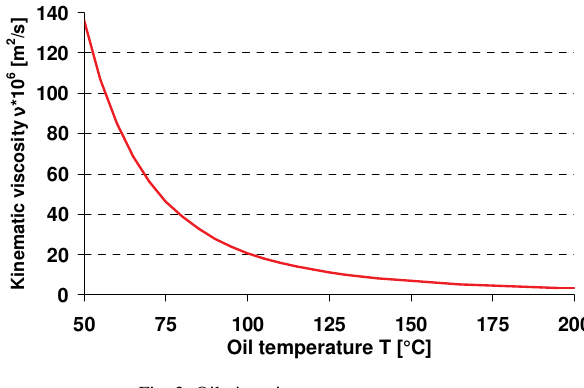
Fig. 3. Oil viscosity versus temperature